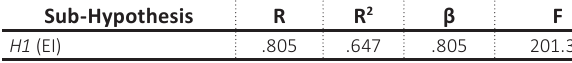
Table 3. Results of the first main hypothesis